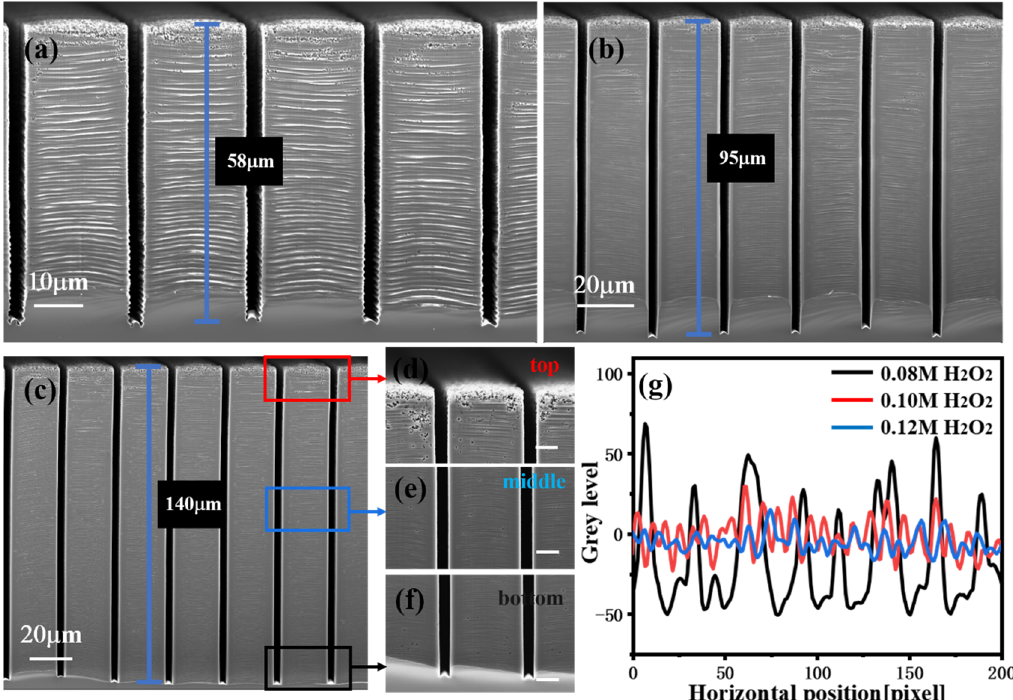
Figure 4. Cross-sectional SEM image of Si microstructures, etched under various etchant solutions composed of HF, H 2 O 2 , and DI water with molar ratio of ( a ) 4.8: 0.08: 50, ( b ) 4.8: 0.10: 50, and ( c ) 4.8: 0.12: 50. SEM images of the top ( d ), middle ( e ), and bottom ( f ) regions of ( c ). The etching time was 17 h, and the etching temperature was room temperature. ( g ) The LER image of micropillars sidewall with different H 2 O 2 concentrations.